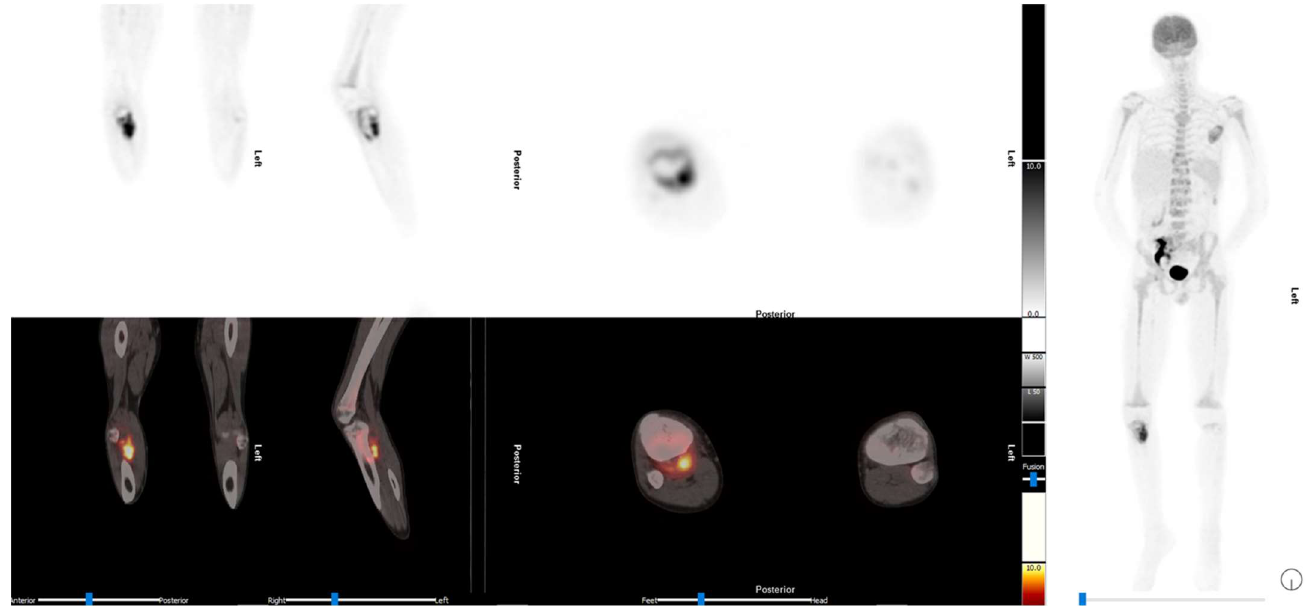
Figure 3. The 2-[ 18 F]FDG PET/CT images of a 14-year-old with relapsed Ewing sarcoma. Diffuse increased bone marrow uptake in the long bones is in keeping with recent colony stimulating growth factor. He also had an autotransplant of a solitary kidney into the pelvis prior to radiotherapy. There are abnormal uptake bone lesions with accompanying soft tissue masses in the scapula and right proximal tibia. This illustrates the superiority of 2-[ 18 F]FDG PET/CT for the detection of soft tissue masses.